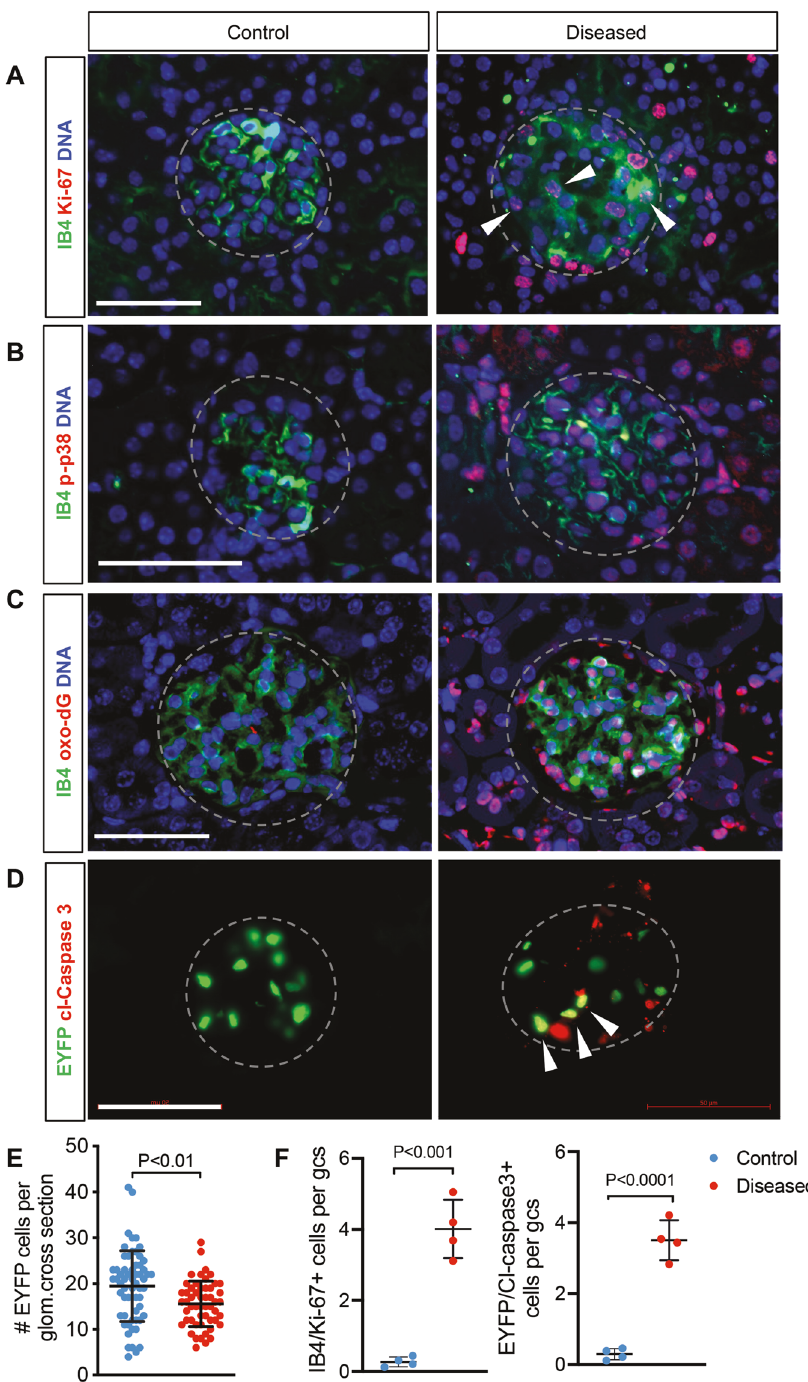
Fig. 6 Podocyte loss results in net GEC loss. A – D Representative immuno fl uorescence images of control and diseased glomeruli as indicated. Glomeruli are outlined in dotted lines. Scale bars, 50 μ m. DNA is counterstained in blue. A Ki-67 (red) and endothelial marker isolectin GS-IB4 (IB4, green). Arrowheads show examples of Ki-67 + and IB4 + cells. B Phospho-p38 MAPK (p-p38, red) and IB4 (green). C DNA damage marker 8-oxo-2 ′ -deoxyguanosine (oxo-dG, red) and IB4 (green). D Cleaved Caspase 3 (cl-Caspase 3, red) and EYFP marking the GECs. Arrowheads show examples of EYFP nuclei that are cl-Caspase 3 + . DNA counterstain is omitted for clarity of double-positive nuclei in yellow. E Average number of EYFP + cells per glomerular cross-section ( n = 61 glomeruli from control mice, 53 from diseased mice, quanti fi ed from three mice per experimental group). P < 0.01 between groups by unpaired two-tailed t -test with Welch ’ s correction. F Average number of IB4/Ki-67 double-positive cells (left) and EYFP/cl-Caspase 3 double-positive cells per glomerular cross-section (gcs) in mice ( n = 4 mice per group, 20 – 30 glomeruli evaluated per mouse). P < 0.001 and P < 0.0001 by unpaired two-tailed t